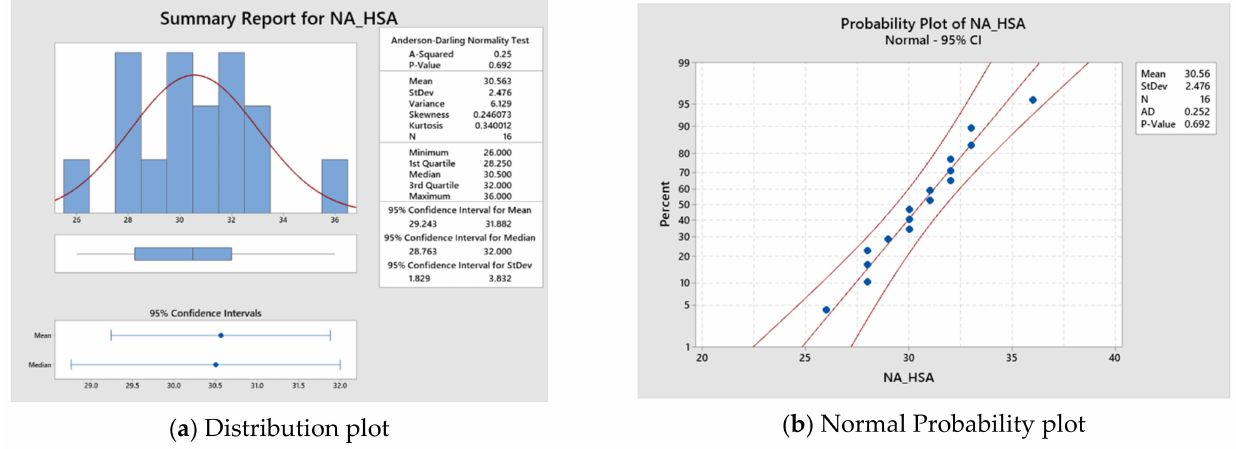
Figure 6. Statistical analyses of the results of the HS algorithm.